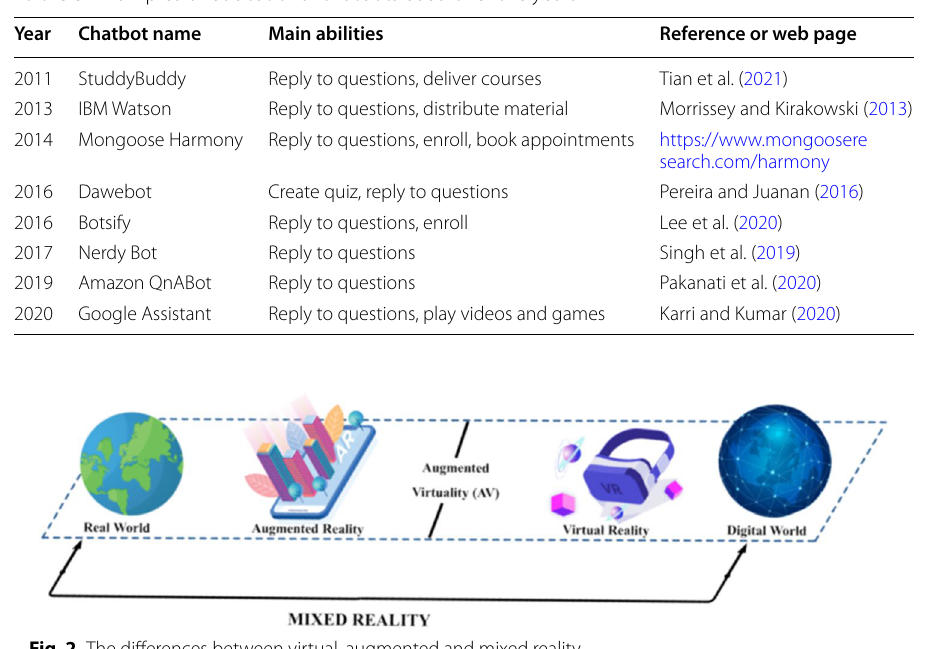
Table 3 Examples of educational chatbots used over the years